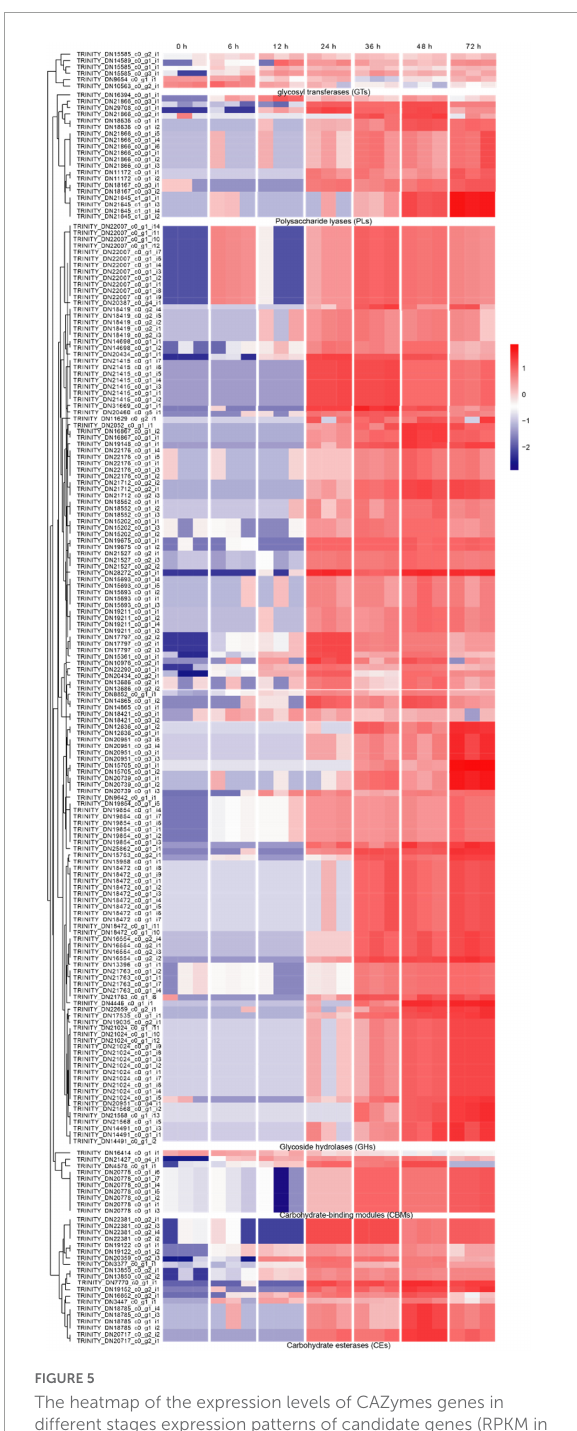
FIGURE5 The heatmap of the expression levels of CAZymes genes in different stages expression patterns of candidate genes (RPKM in log10-scale) for CAZymes were represented in heatmaps (numerals indicate hours after inoculation onto tobacco).